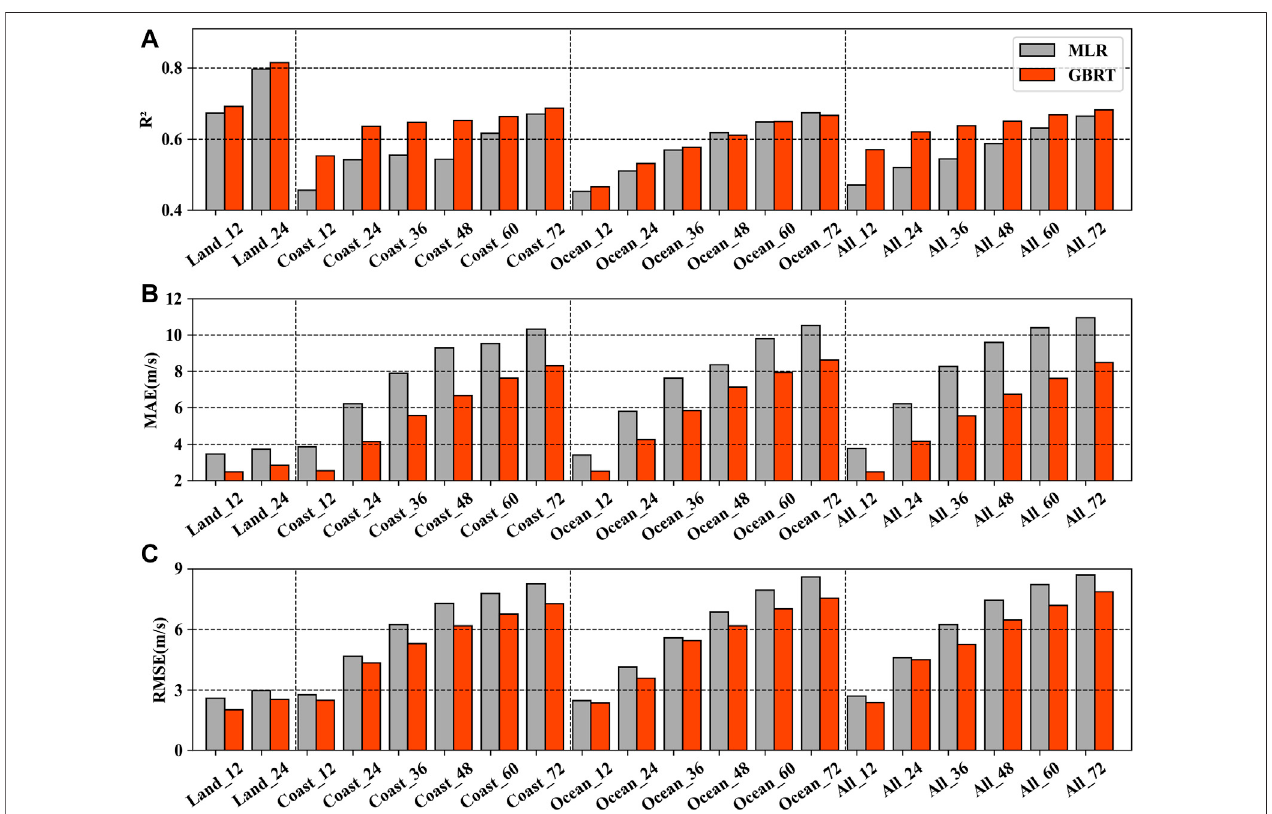
FIGURE 8 | Performance comparisons between the MLR model and GBRT model in terms of (A) R 2 , (B) MAE, and (C) RMSE for the TCs intensity change prediction basedon the STIdatafrom 2000to2015. TheLand,Coast, Ocean, and All from the x -axis labels refer toTCsover land,near thecoast, over theopen ocean, and all TC samples,